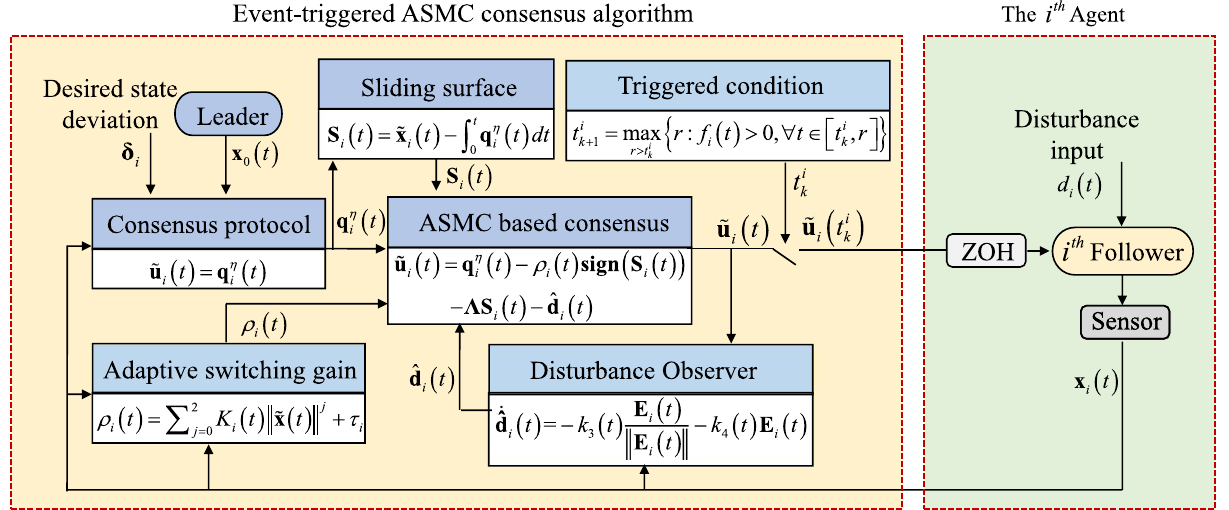
Figure 1. The structure of proposed event-triggered ASMC based consensus